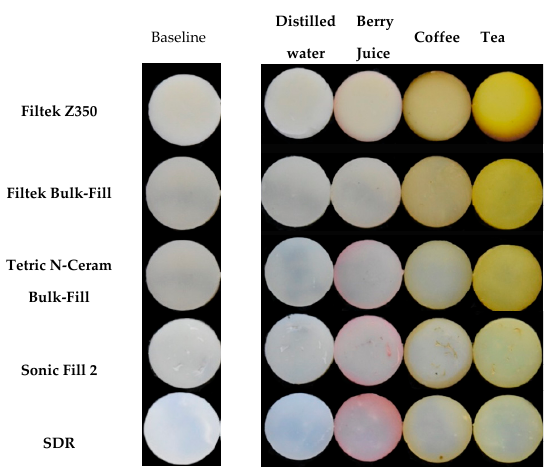
Figure 1. Photographs of specimens from each group of the study at baseline and after 90 days of immersion in the staining solutions.